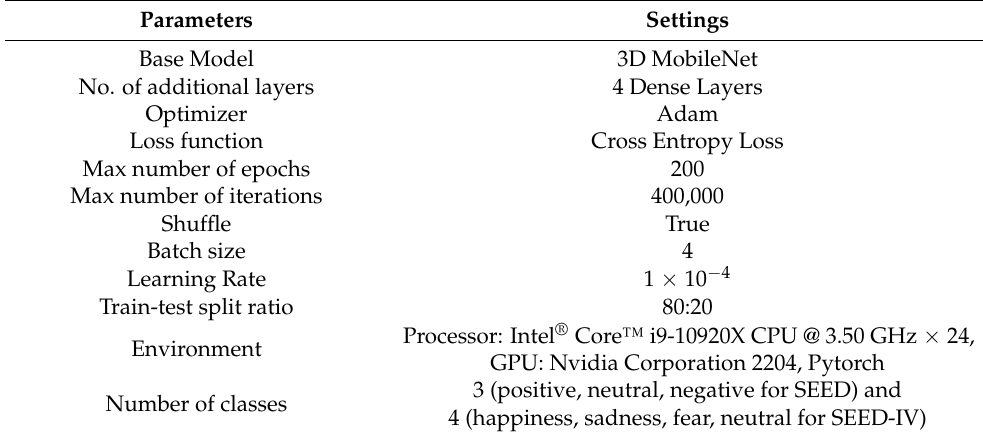
Table 2. Properties of layers following the 3D MobileNet base model.